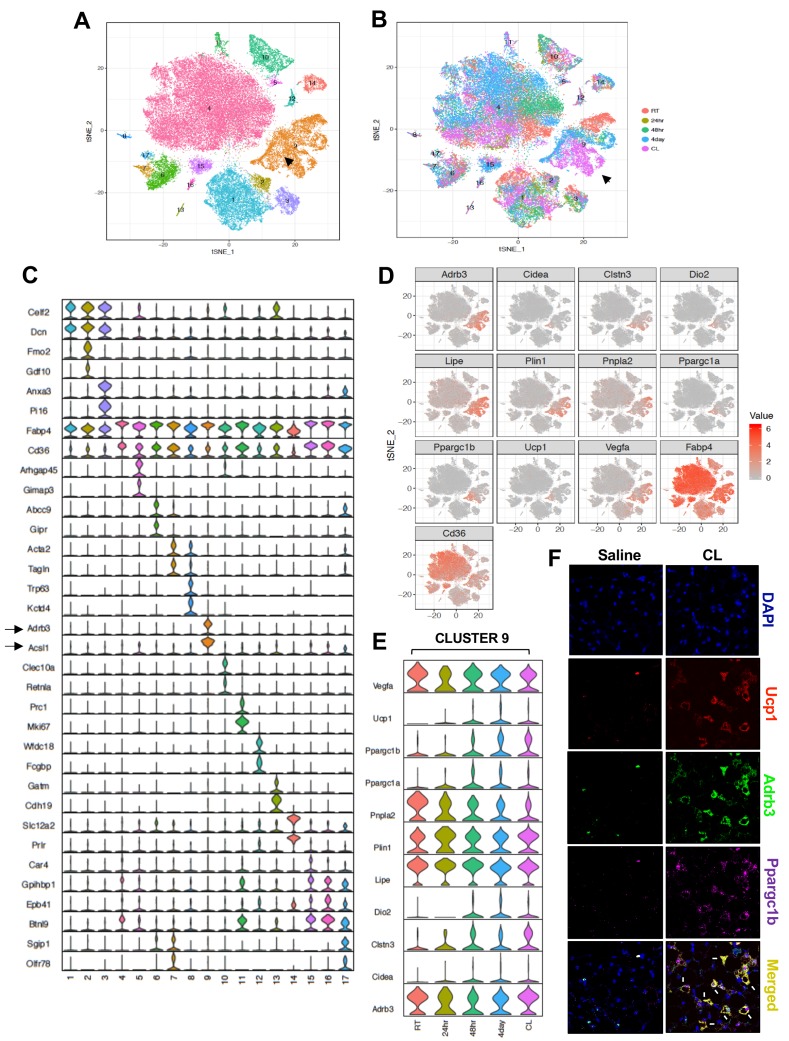
Transcriptomic visualization of thermogenic adipocytes in iWAT.(A) Aggregated tSNE-plot showing 17 clusters from ~54,000 adipocytes derived from iWAT of mice at RT, cold-exposed (24 hr, 48 hr, and 4 days), or treated with CL for 4 days at 1 mg/kg/day. Each colored dot is an adipocyte that falls into a cluster based on transcriptomic signature. (B) tSNE-plot showing indicated treatment-dependent sub-clustering of aggregated clusters shown in (A). Black arrow indicates the Type nine adipocyte cluster. (C) Normalized expression values of the top two adipocyte subtype-specific cluster genes from (A and B) plotted as violin plots with clusters as rows and genes as columns. (D) tSNE-plot showing distribution of indicated genes from adipocytes from (A). (E) Normalized expression values of indicated genes in the Type nine adipocyte cluster under different treatment condition plotted as violin plots with treatment conditions as rows and genes as columns. (F) RNAScope FISH (see Materials and methods) of indicated probes from iWAT of mice treated with saline or CL for 4 days at 1 mg/kg/day.